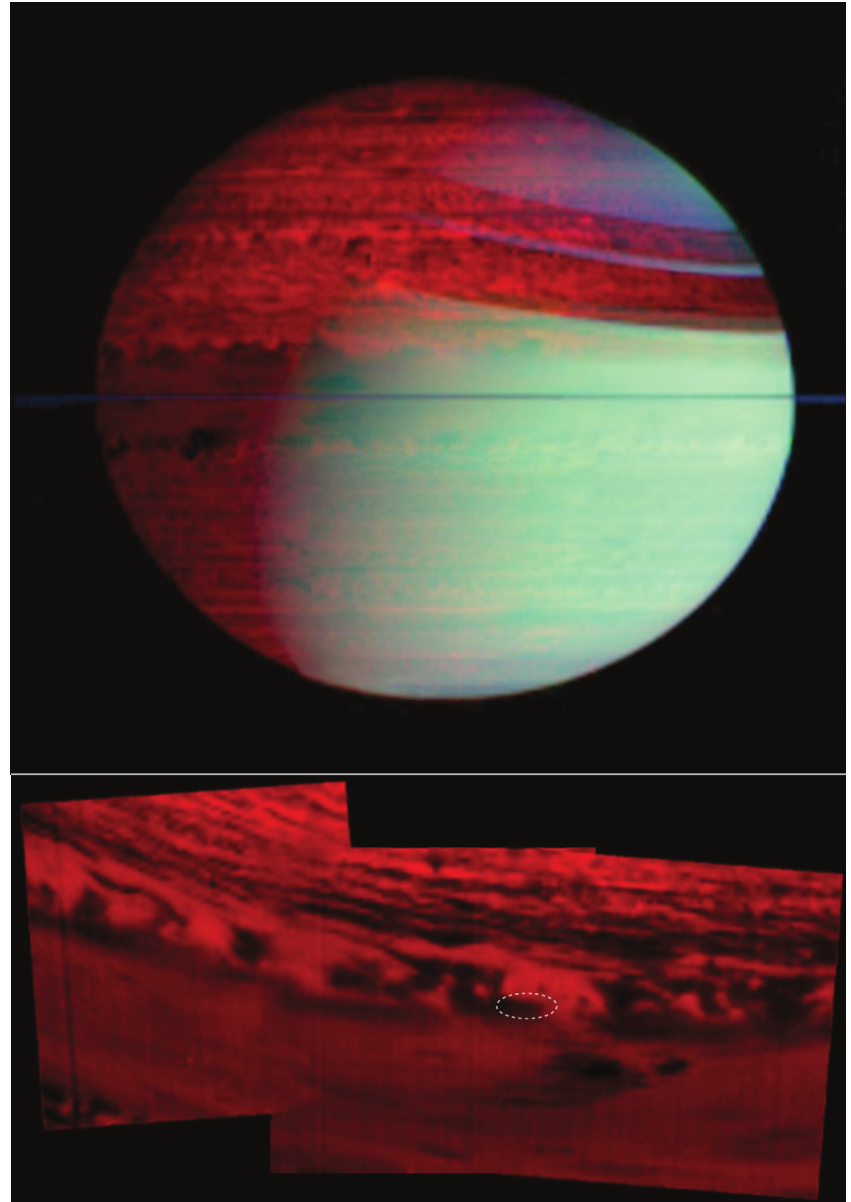
Figure 7. Images of Saturn from Cassini-VIMS. Top: False-color mosaic of Saturn from February 2006 showing thermal infrared radiation at 5.02- µ m (in red) and scattered sunlight at 1.07 µ m and 2.71 µ m (in blue and green, respectively). Discrete clouds appear silhouetted against the glow of Saturn’s thermal emission at 5- µ m, while the rings cast a shadow upon Saturn’s northern hemisphere. Bottom: The last images from VIMS, captured on 14 September, 2017, as the spacecraft made its final descent towards Saturn. Thermal emission at 5 µ m appears brighter where the cloud opacity is less. The dotted ellipse marks the approximate location where the Cassini spacecraft soon thereafter entered into the atmosphere, concluding the mission. Image credits: NASA/JPL-Caltech/University of Arizona